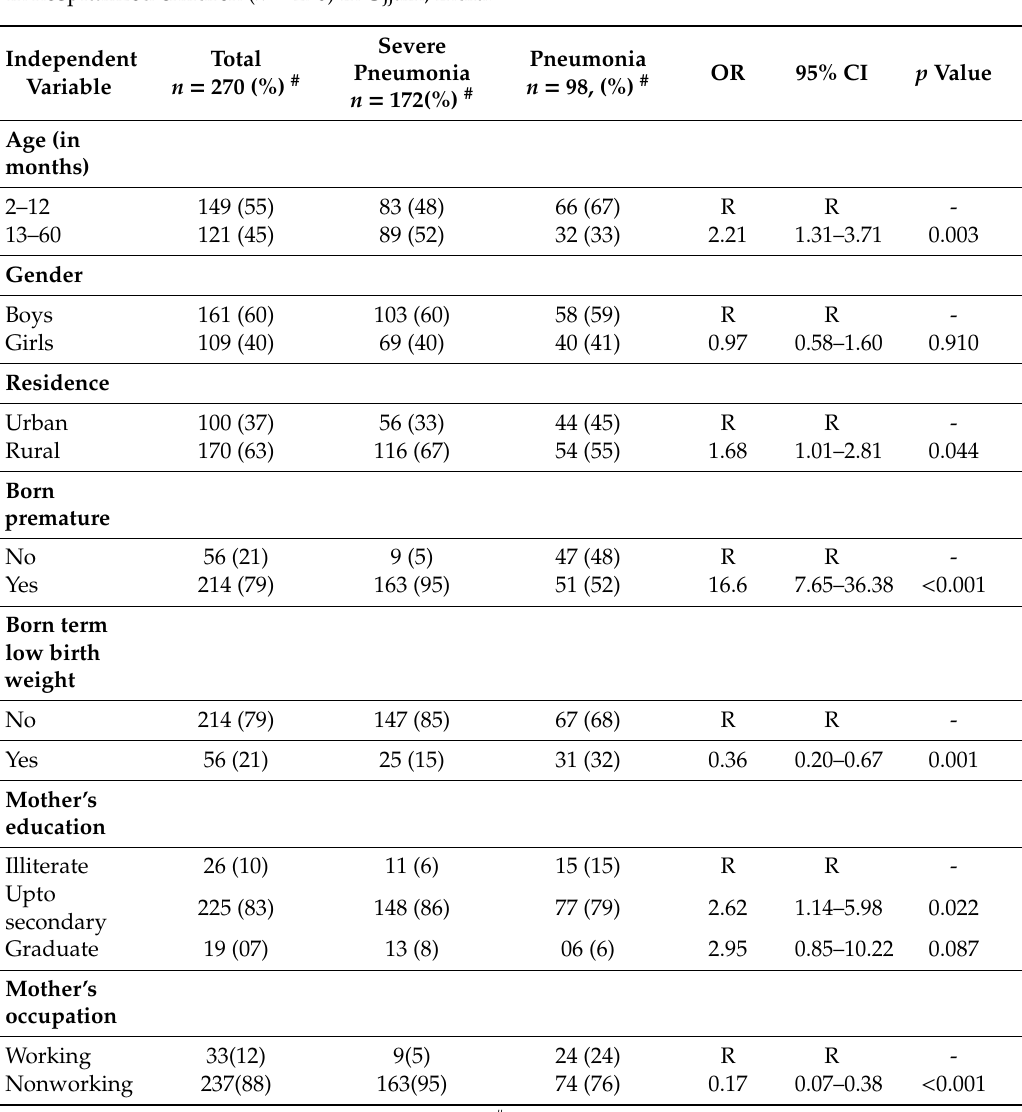
Table2. Bivariateassociationsofsocio-demographicandbirth-relatedcovariateswithseverepneumonia in hospitalized children ( n = 270) in Ujjain,